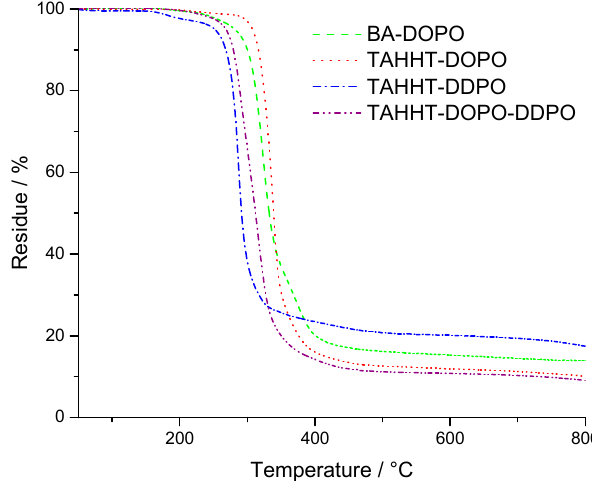
Figure 2. TG-curves of phosphorus containing polyacrylamides measured under N 2 -atmosphere.